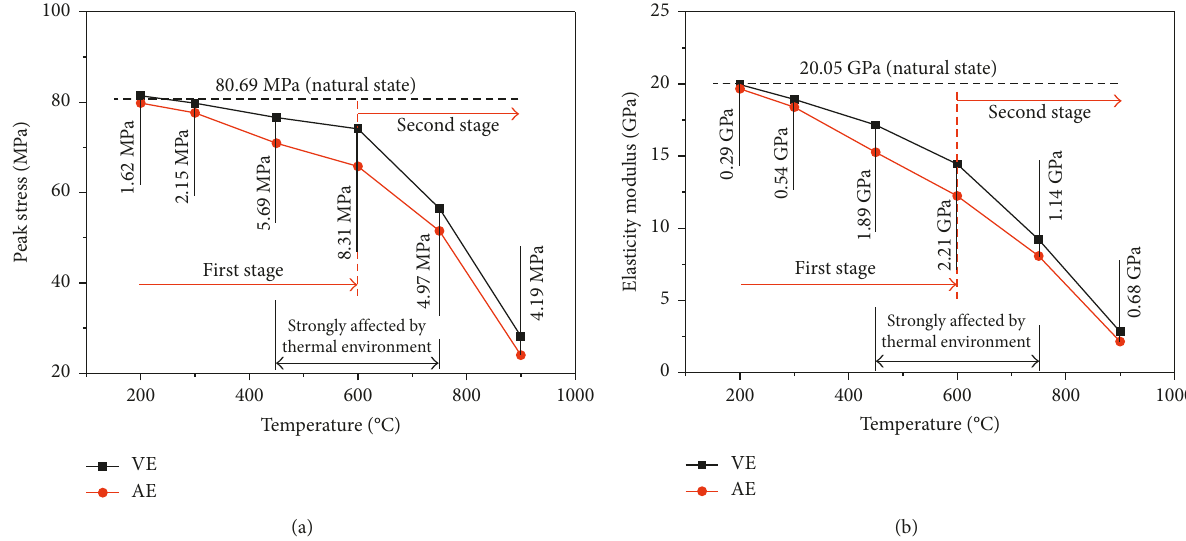
Figure 3: Effect of temperature on the mechanical parameters of marble specimens: (a) peak stress and (b) elasticity